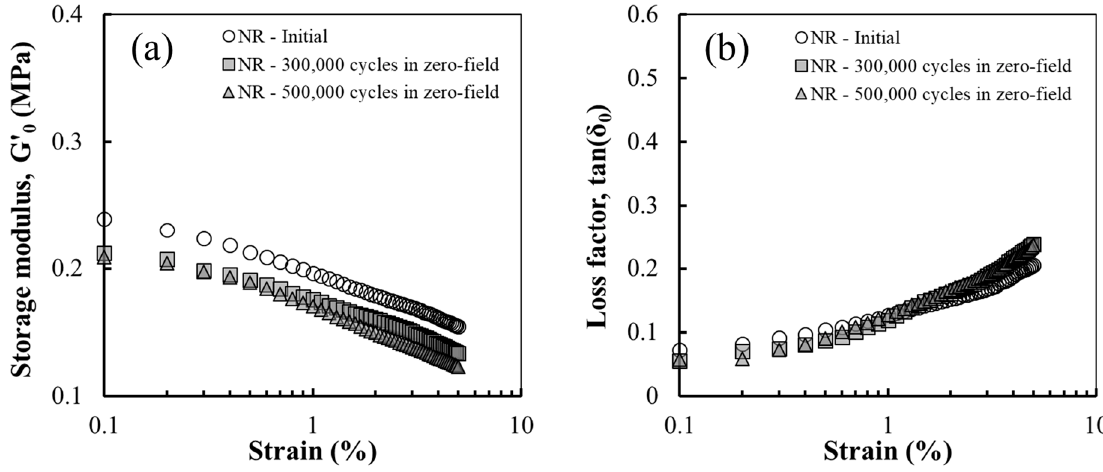
Figure 3. ( a ) G ′ 0 and ( b ) tan( δ 0 ) of the NR before and after cyclic shear